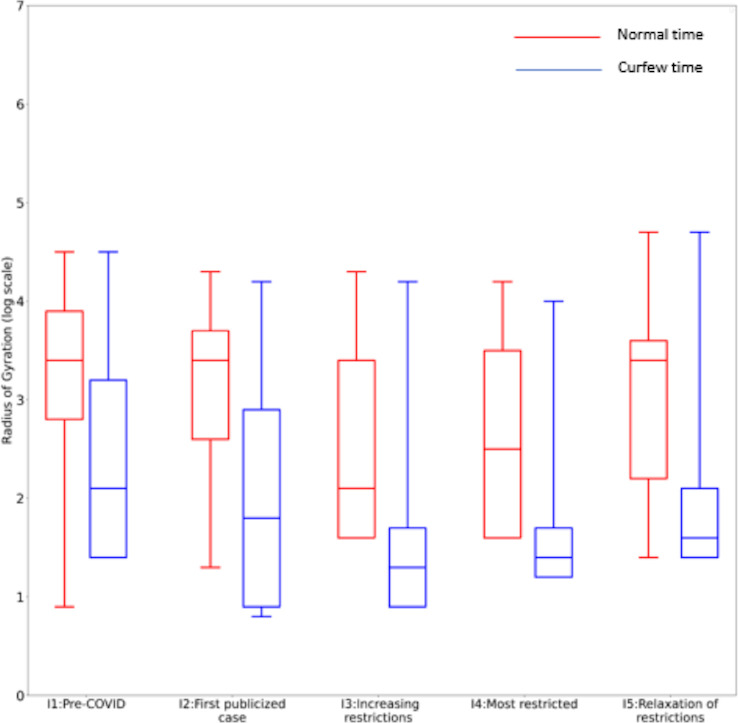
Daily RoG values during normal and curfew times in each interval (meters).